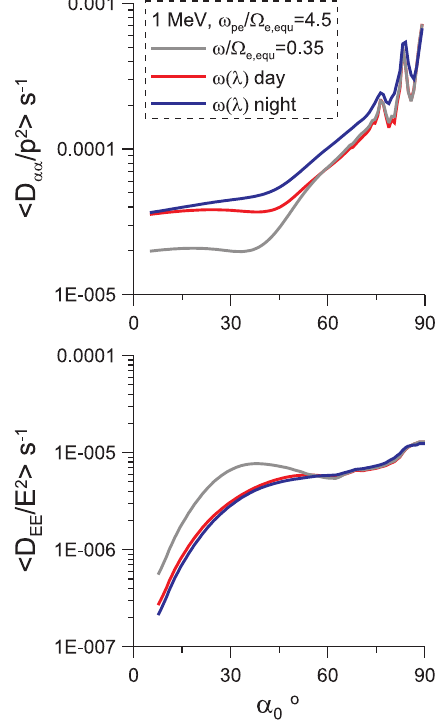
Figure 3. Pitch angle and energy diffusion coefficients as a function of electron equatorial pitch angle for 1MeV electrons interacting with parallel whistler waves (wave parameters are the same as in Glauert and Horne, 2005) at L = 5. Grey colour shows results for “standard” constant wave frequency, while colour shows results for wave frequency varying with latitude (parameters from Table 1) as shown in Fig. 1 in the dayside (red) and nightside